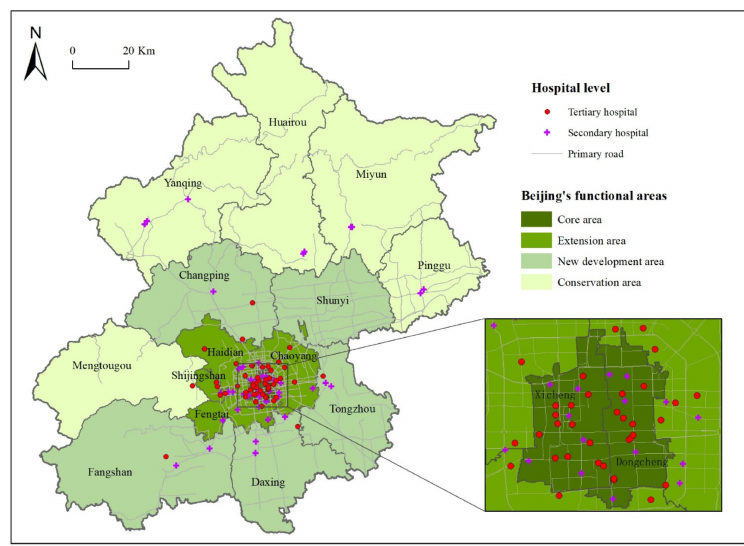
Figure 1. The distribution of destination hospitals in